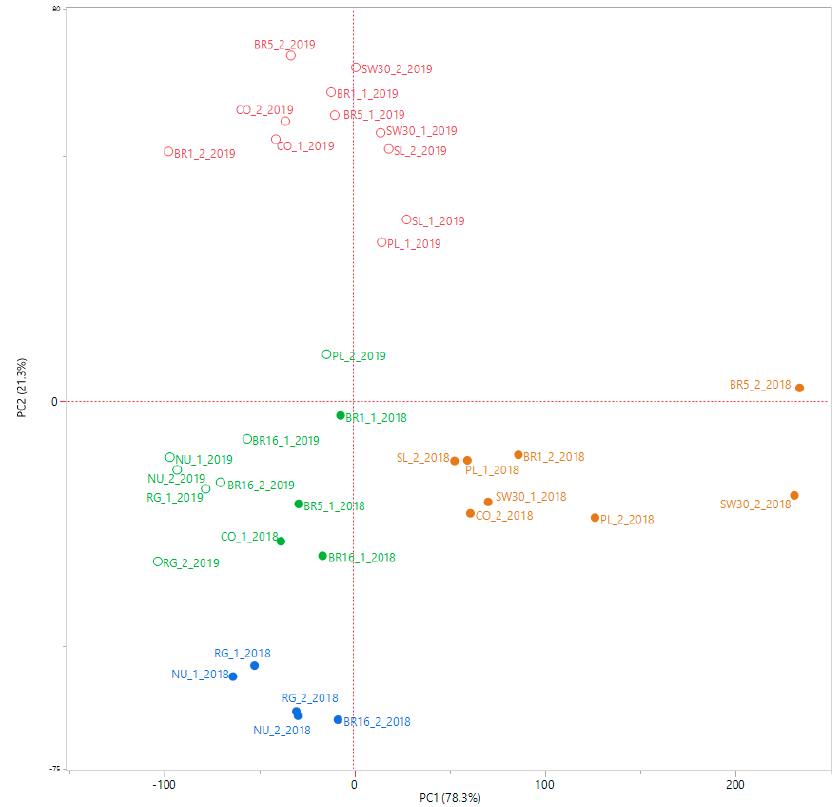
Figure 3. Principal component analysis (PCA) on total phenols, flavonoids, and SVglys. Each genotype is followed by the indication of harvest time (1 = first harvest; 2 = second harvest) and crop age (2018 and 2019).